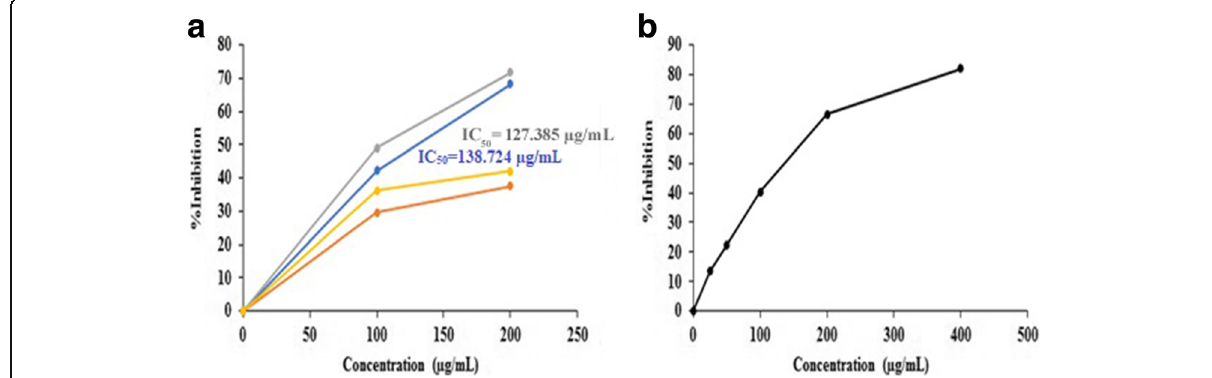
Fig. 7 a Comparison of elastase inhibition capacity of methanolic extracts of Nyctanthes arbor-tristis leaves (orange), unripe fruit pulp of Aegle marmelos (grey), terminal meristem of Musa paradisiaca flower (blue) and ripe fruit pulp of Aegle marmelos (yellow). b Elastase inhibition capacity of PHF1 (y-axis) at various concentrations